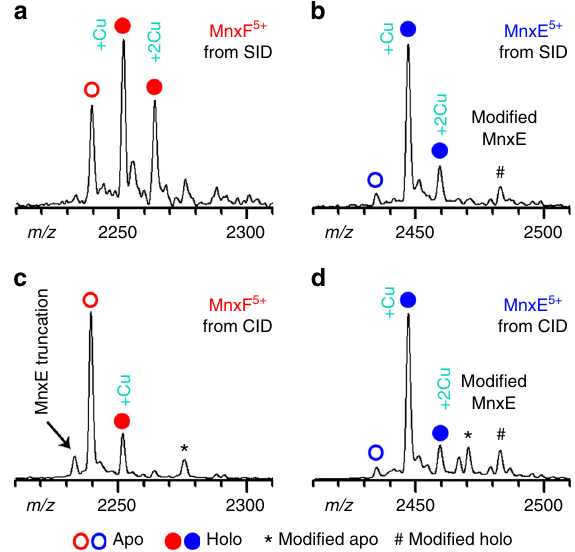
Fig. 5 Examining metal-binding stoichiometry of in situ dissected MnxE and MnxF subunits. Zoomed-in view of the mass spectra for monomers released from Mnx, MnxF and MnxE, by SID ( a , b ) or CID ( c , d ). Peaks corresponding to the apo protein are labeled with open circles; copper bound proteins are labeled with fi lled circles. Asterisks (*) annotate protein peaks thought to arise from arti fi cial modi fi cation during protein expression and puri fi cation; the pound sign (#) represents the modi fi ed protein bound to copper. MnxE primarily binds one copper with strong af fi nity. MnxF binds 0 – 2 copper; the stoichiometry is variable depending on sample conditions, implying a weaker af fi nity to copper than MnxE. In CID, most of the weakly bound copper on MnxF was lost after the subunits were released from the complex due to protein unfolding. Because minimal unfolding of the subunits occurs in SID, the weakly bound ligands can be preserved (see Supplementary Fig. 6 and Supplementary Note 4 for more